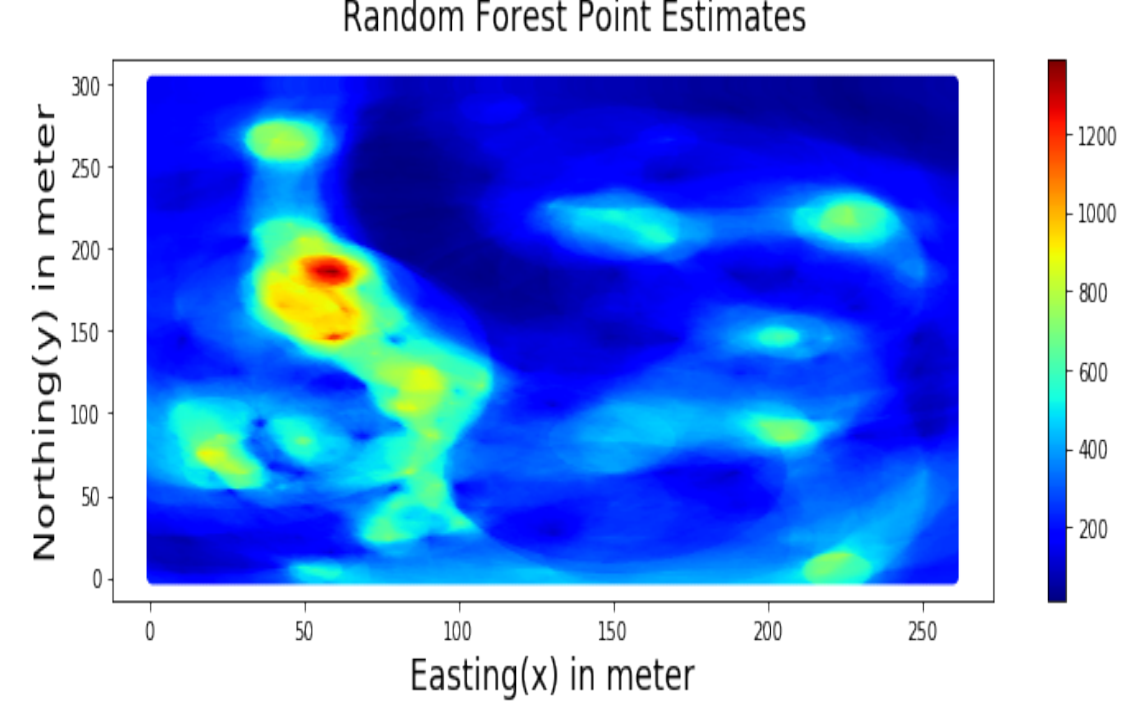
Figure 10. RF-based Point Estimates for Walkerlake dataset.